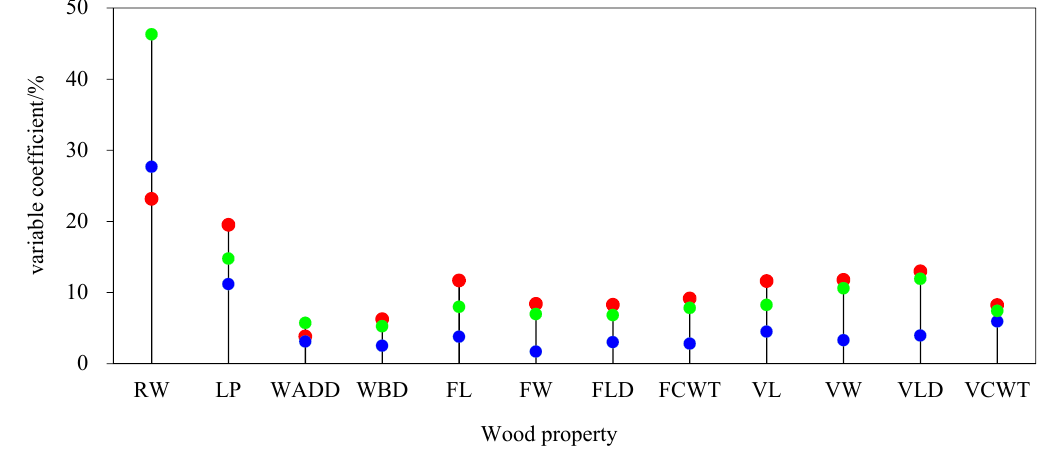
Figure 8. The radial variation of vessel wall-lumen ratio ( A ), vessel lumen-width ratio ( B ) and vessel length-width ratio ( C ) versus cambial age and the mean of differently aged S. superba.